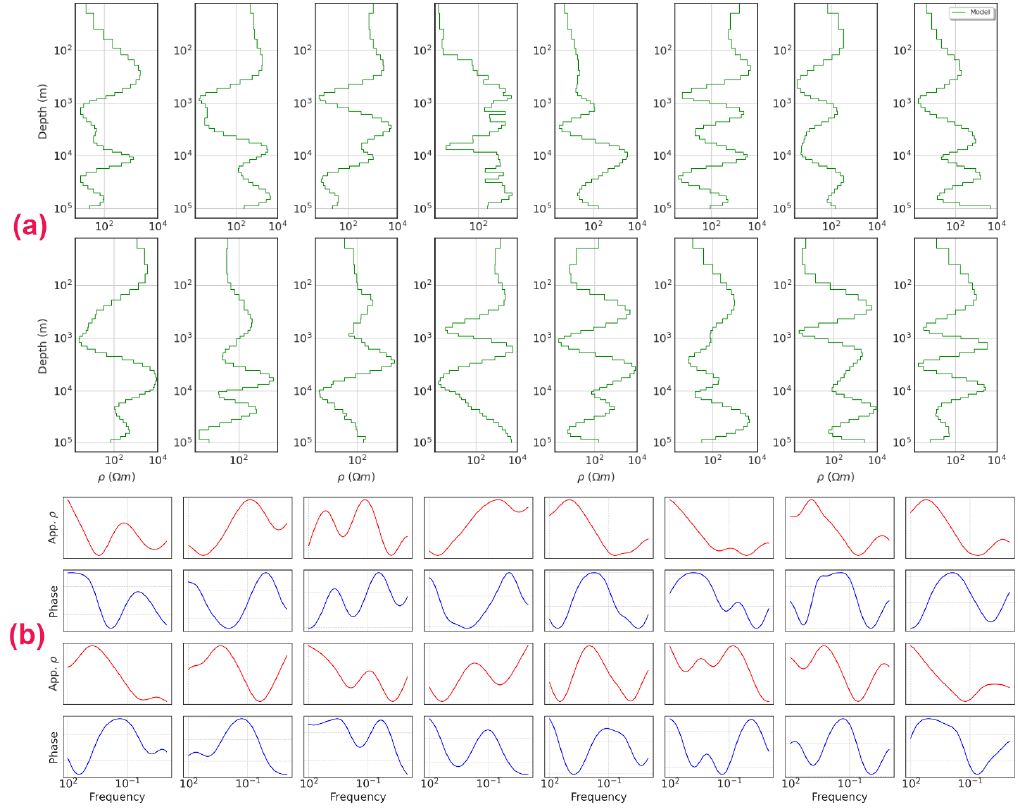
Figure 3. ( a ) Samples of generated synthetic models that are selected randomly from the testing datasets; ( b ) calculated apparent resistivity and phase from the synthetic geoelectric models.